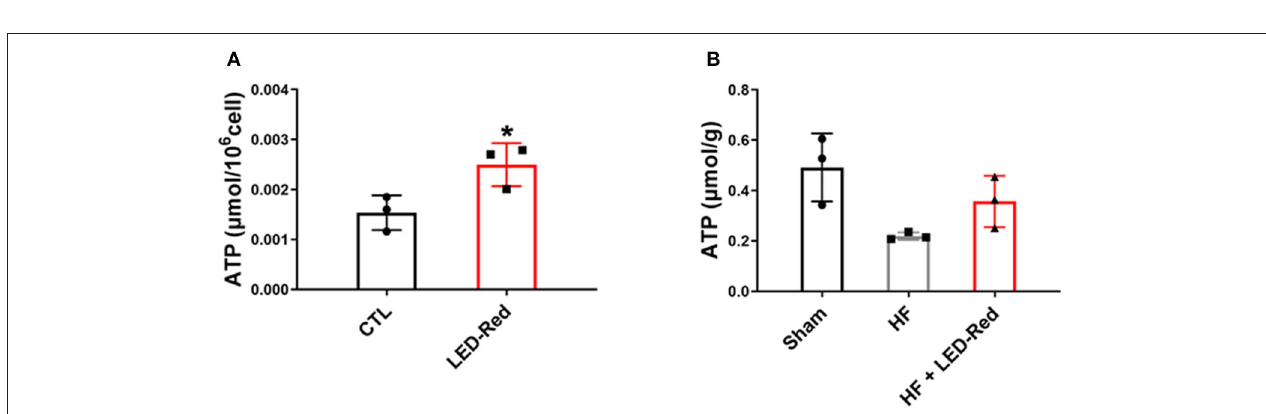
FIGURE 6 | LED-Red irradiation increases ATP content in cardiomyocytes and cardiac tissue. (A,B) NADPH assays was applied to measure the content of ATP in isolated ventricular myocytes (A) , and cardiac tissue (B) . n = 3, * P < 0.05 vs. CTL. Data are expressed as the mean ± SEM.